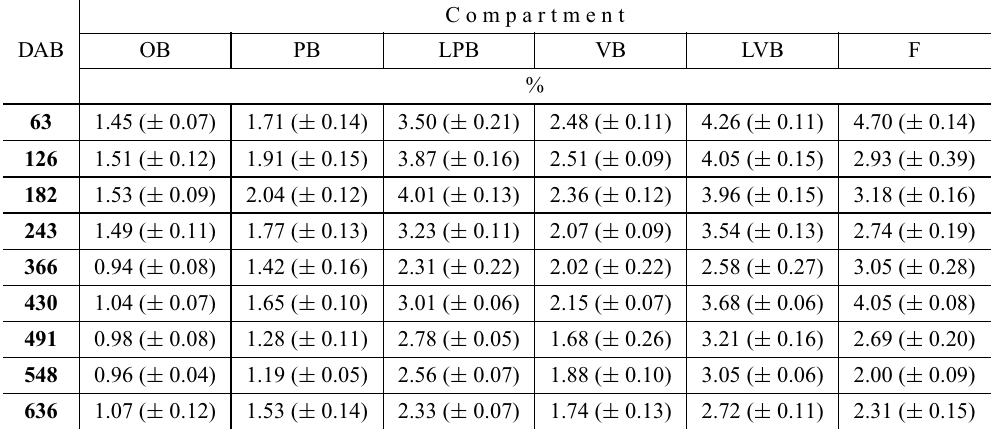
Means and standard errors (s m ) of total-N concentration (C N ) as a function of time (DAB = days after beginning, starting Sept 1, 2003) for the different aerial compartments of the coffee plant, measured during mass-spectrometry.